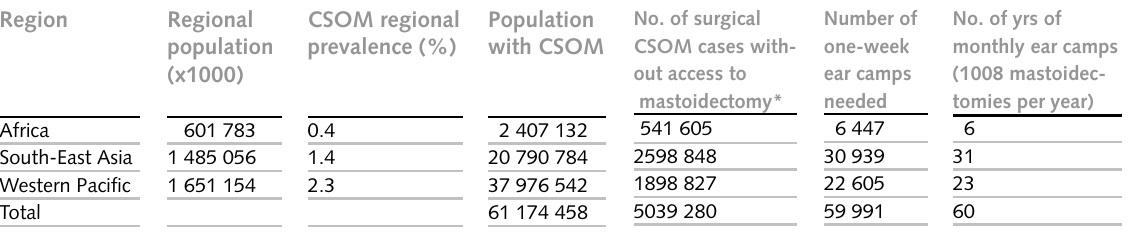
* Regardless of the type of mastoidectomy, the more ossicular remnants that are present the easier the tympanoplasty. See Chang & Chen